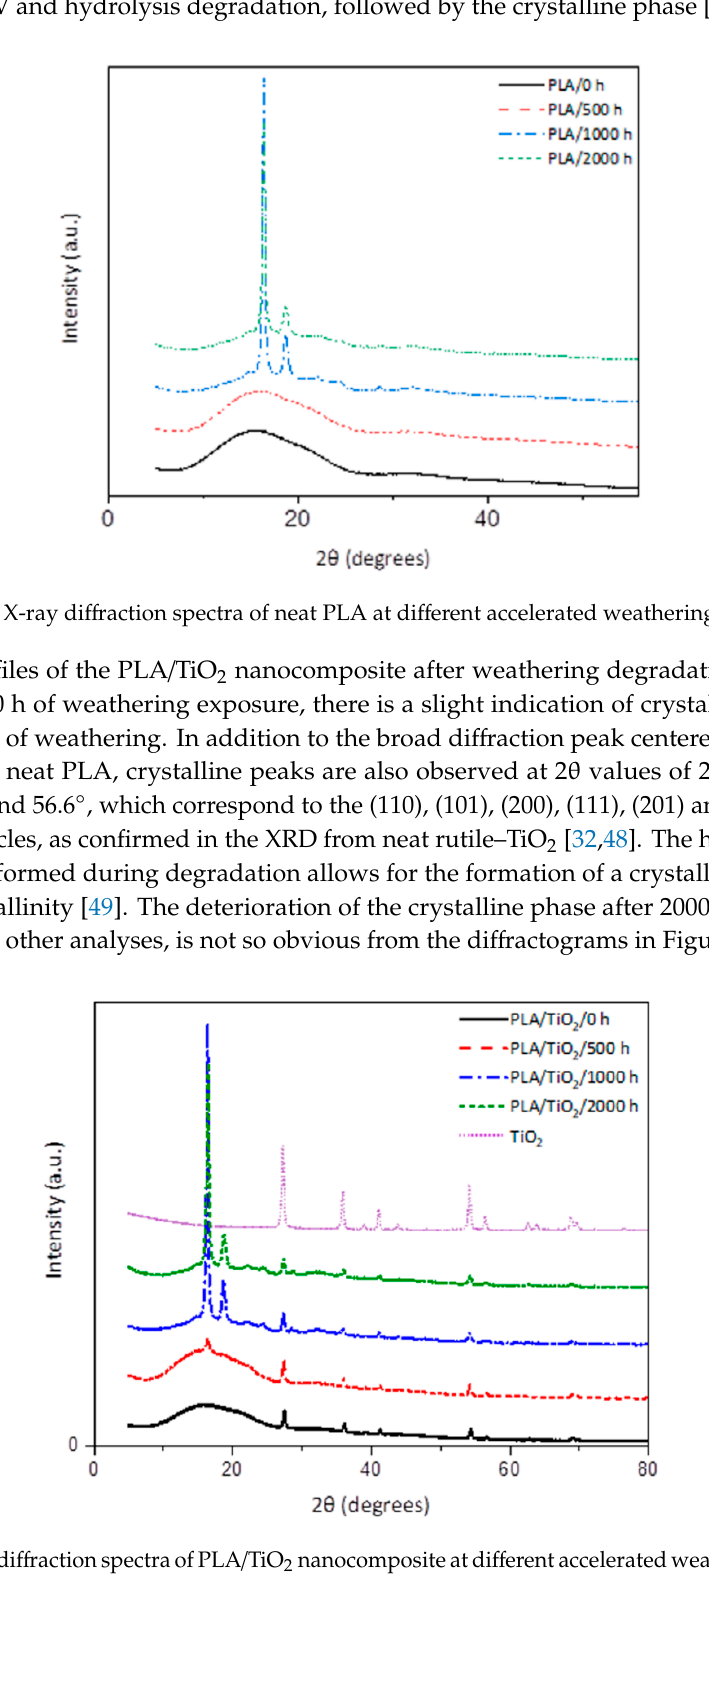
Figure 5. X-ray diffraction spectra of neat PLA at different accelerated weathering times.